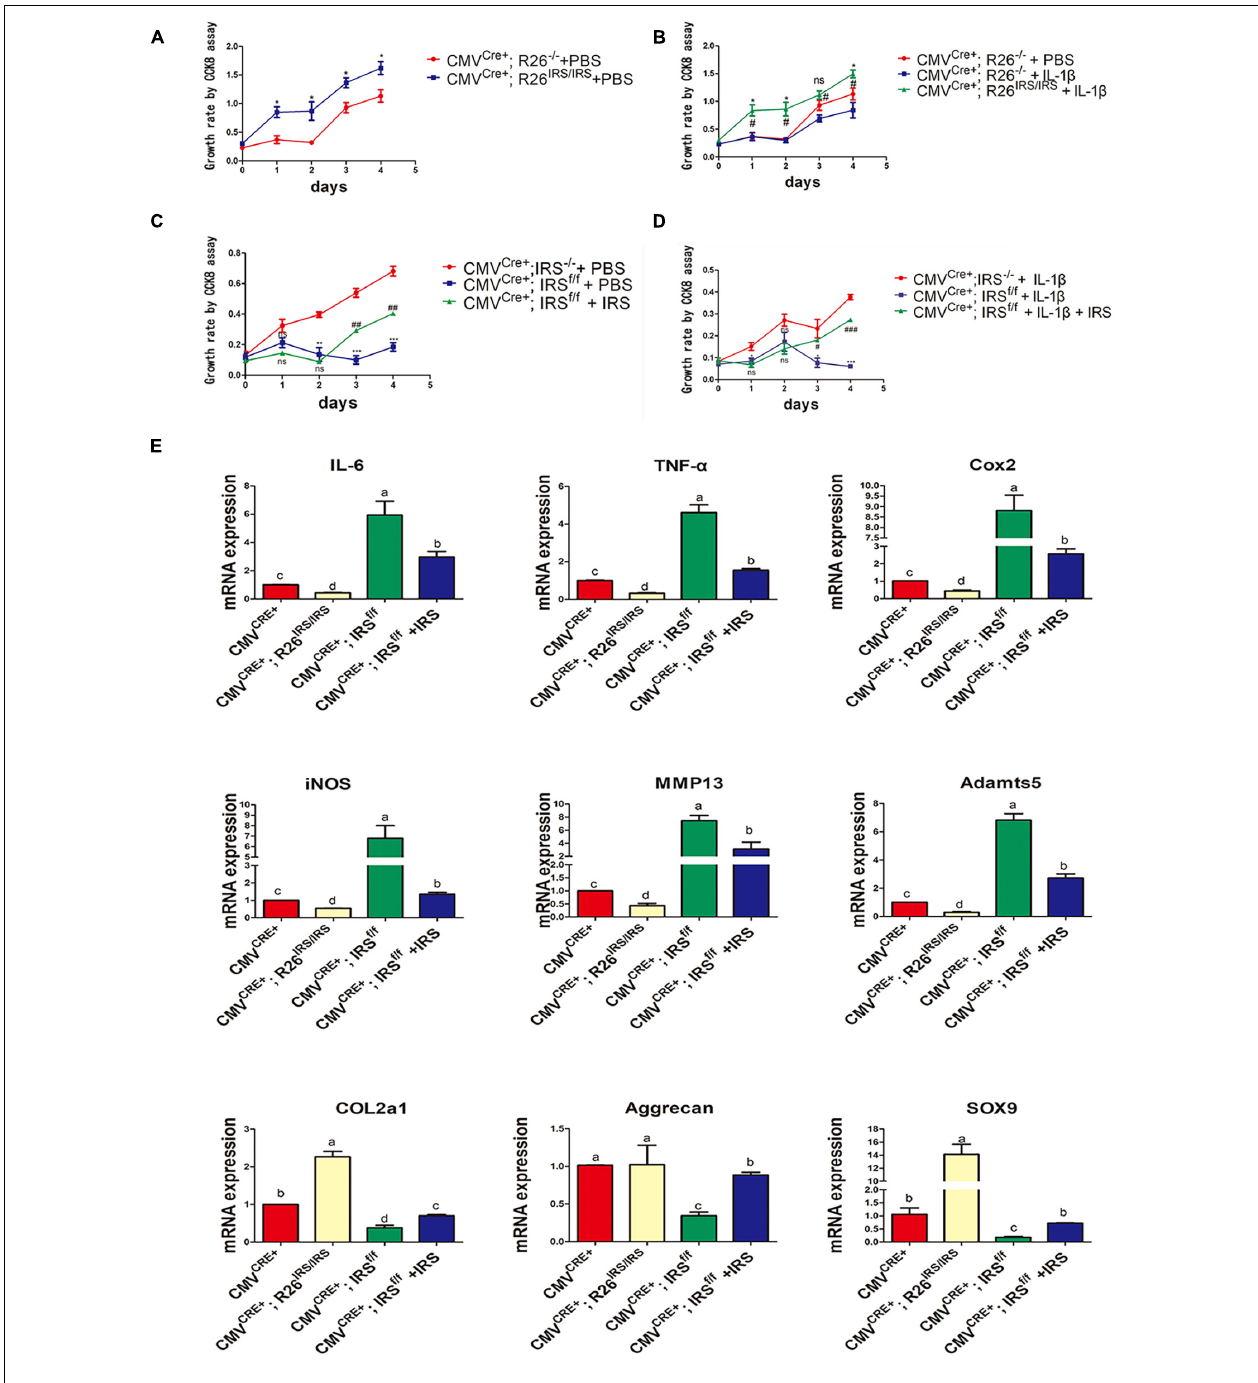
FIGURE 6 | Proliferation and inflammation genes expression of primary chondrocytes isolated from irisin KO and KI mice. (A) Proliferation change in irisin KI mice in normal condition (* p < 0.05). (B) Proliferation change in irisin KI mice in inflammation conditions induced by IL-1 β ( ns p > 0.05, *CMV Cre + ; R26 − / − + IL-1 β vs. CMV Cre + ; R26 IRS / IRS + IL-1 β , # CMV Cre + ; R26 − / − + PBS vs. CMV Cre + ; R26 IRS / IRS + IL-1 β , *, # p < 0.05). (C) Proliferation change in irisin KO mice in normal ( ns p > 0.05, *CMV Cre + ; IRS − / − + PBS vs. CMV Cre + ; IRS f / f + PBS, # CMV Cre + ; IRS f / f + PBS vs. CMV Cre + ; IRS f / f + PBS + IRS, **, ## p < 0.01, ***, ### p < 0.001). (D) Proliferation change in irisin KO mice in inflammation conditions induced by IL-1 β (ns p > 0.05, *CMV Cre + ; IRS − / − + IL-1 β vs. CMV Cre + ; IRS f / f + IL-1 β , # CMV Cre + ; IRS f / f + IL-1 β vs. CMV Cre + ; IRS f / f + IL-1 β + IRS, *, # p < 0.05, ***, ### p < 0.001). (E) Some inflammatory cytokines, inflammatory mediators, catabolic enzymes and anabolic genes expression both in primary chondrocytes isolated from irisin KO and KI mice. The comparing data between groups shown in lowercases (a, b, c, and d) are mean values with statistical significance ( P < 0.05).